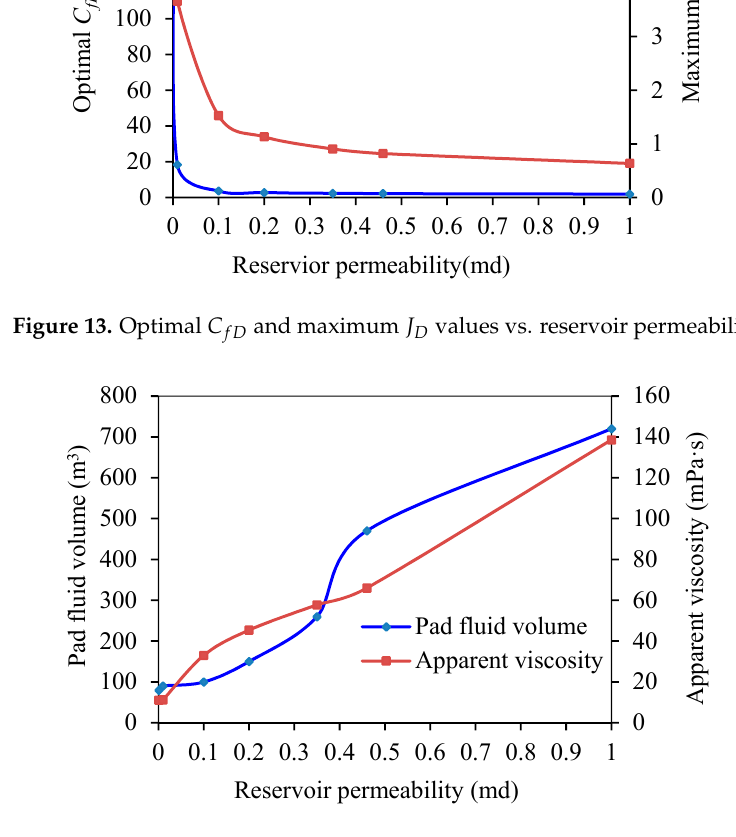
Figure 13. Optimal (cid:1829) (cid:3033)(cid:3005) and maximum (cid:1836) (cid:3005) values vs. reservoir permeability.